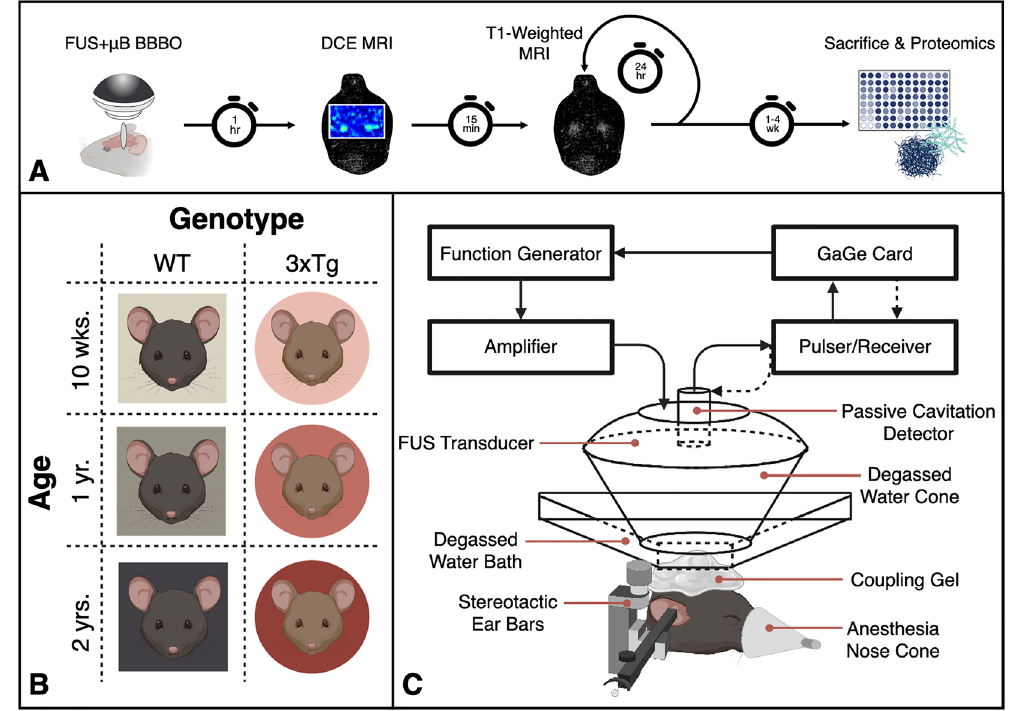
Figure 1. Experimental design. ( A ) Overview of experimental timeline and workflow. (Elements created with BioRender.com) ( B ) Experimental cohorts used throughout the study. WT and 3xTg mice aged 10 weeks, one year or two years were used for the present study, with 5–9 animals per group. (Created with BioRender.com) ( C ) Schematic of Focused Ultrasound setup. (Created with